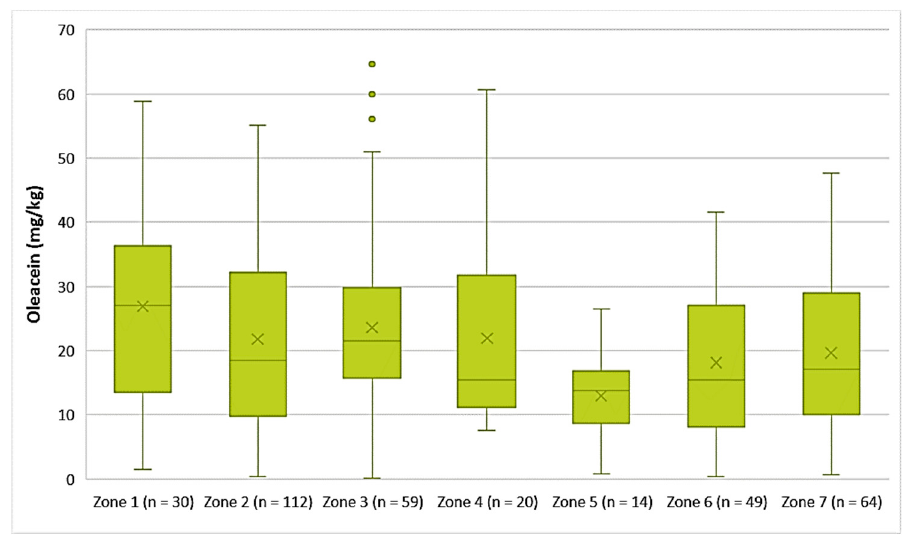
Figure 10. Concentration of oleacein (mg/kg) in EVOOs from the seven zones (Zones 1–7) of the island of Lesvos.